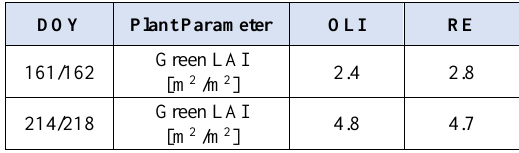
Table 3: Plant Parameter retrieved from OLI and RE